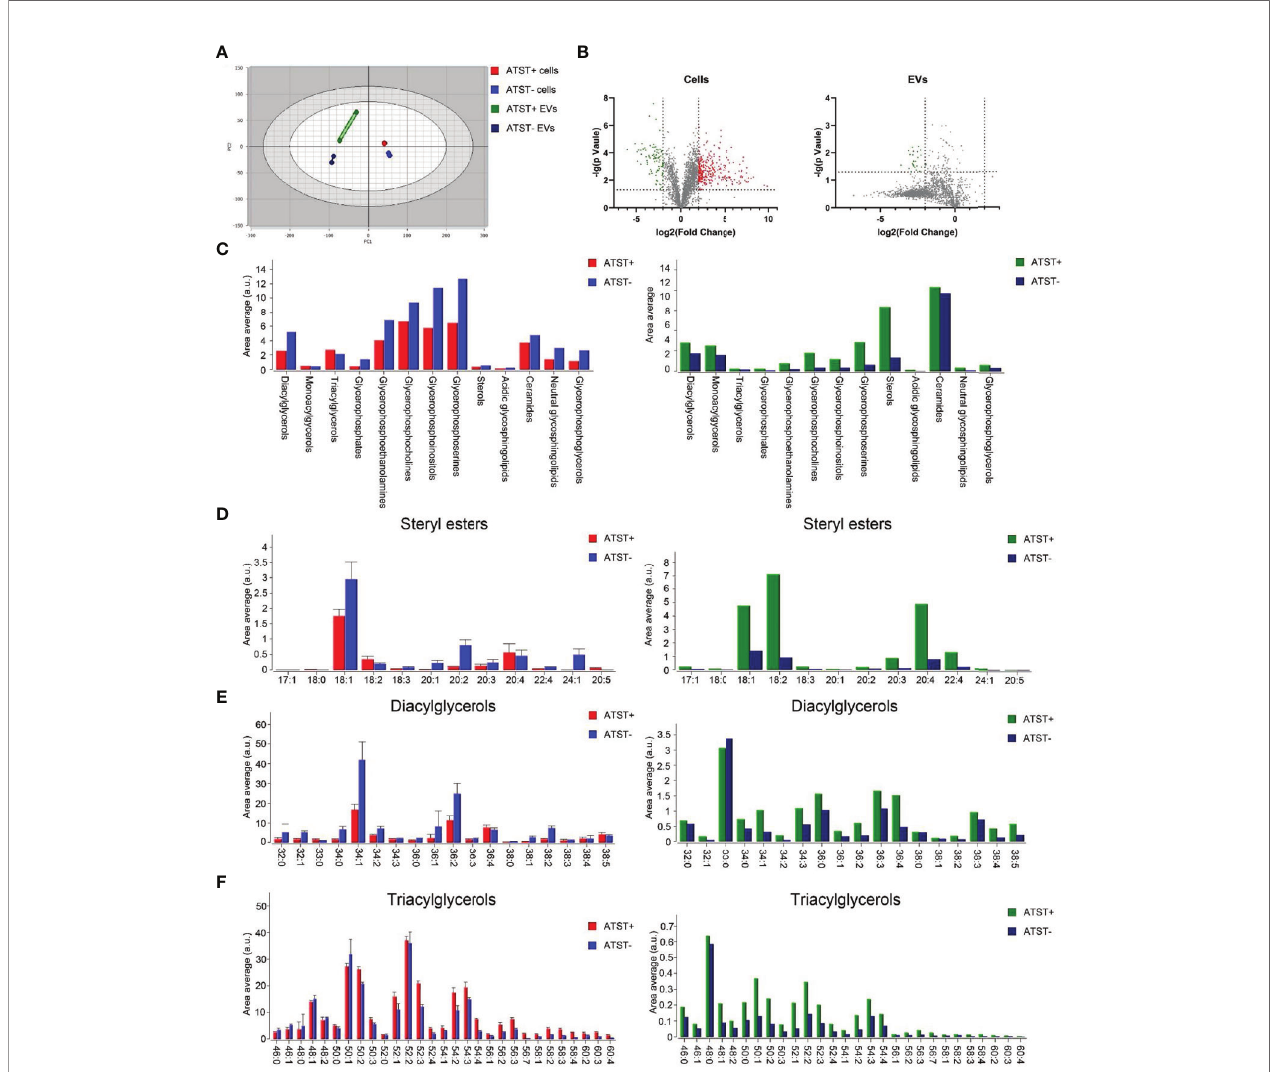
FIGURE 4 | (A) PCA plot lipid feature of each group (Red: Atorvastatin+ (ATST+) cells; Blue: ATST- cells; Green: ATST+ EVPs; Blue: ATST- EVPs). (B) Volcano plot comparing the lipid composition in cell samples (left) and EVP samples (right). (C) Lipid abundance plot by lipids in cell samples and EVP samples. (D) Difference in abundances of stearyl ester between cell samples (left) and EVP samples (right). (E) Difference in abundances of DG between cell samples (left) and EVP samples (right). (F) Difference in abundances of TG between cell samples (left) and EVP samples